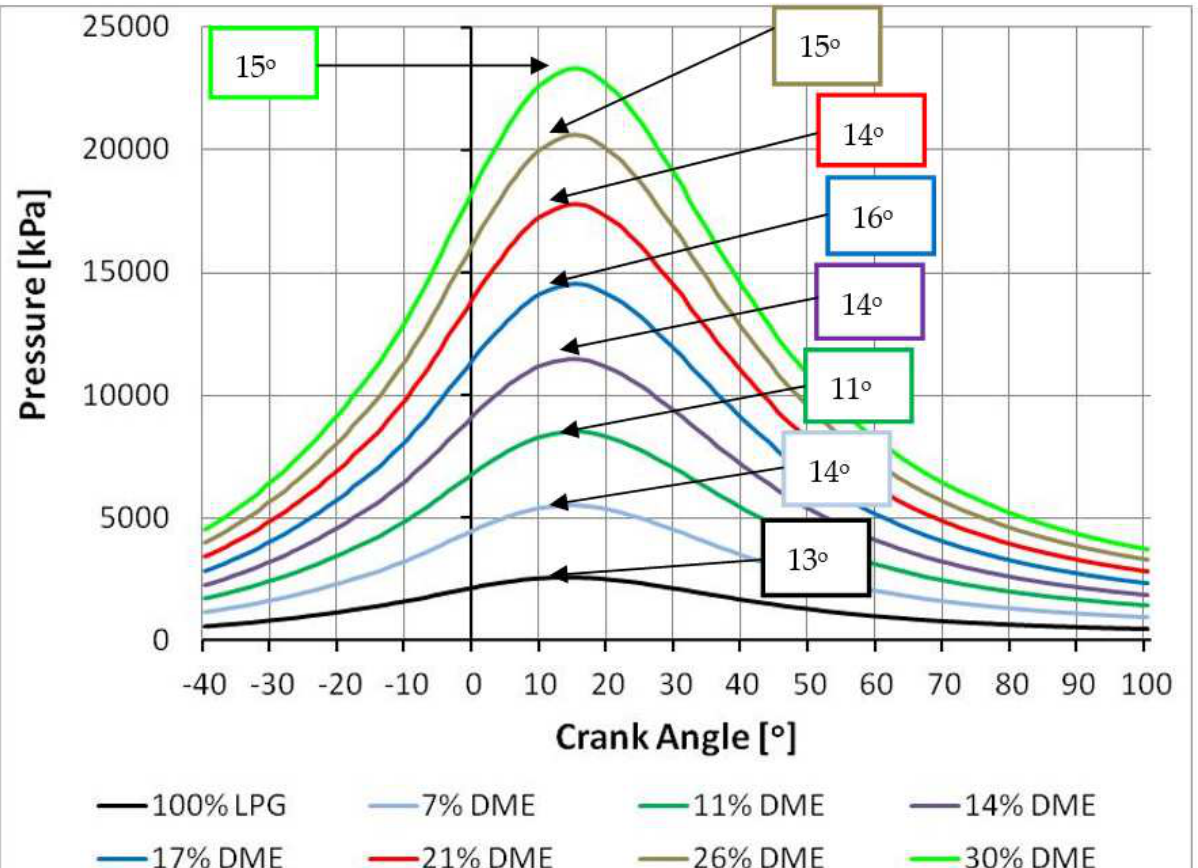
Figure 8. Maximum in-cylinder pressure value vs. crank angle (33% load and 3000 RPM, presented as the sum of the consecutive data